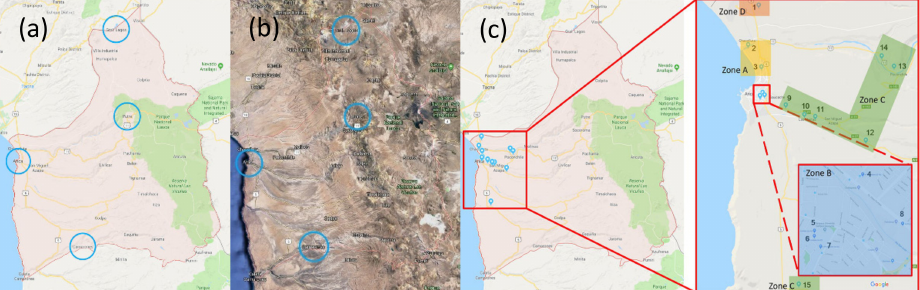
Figure 1. ( a ) Left: Google map of Arica and Parinacota Region. The four communes are shown inside a blue circle. ( b ) Right: Satellite Google map of Arica and Parinacota Region. Communes are highlighted again. ( c ) Mapping of the inspected sites within Arica’s